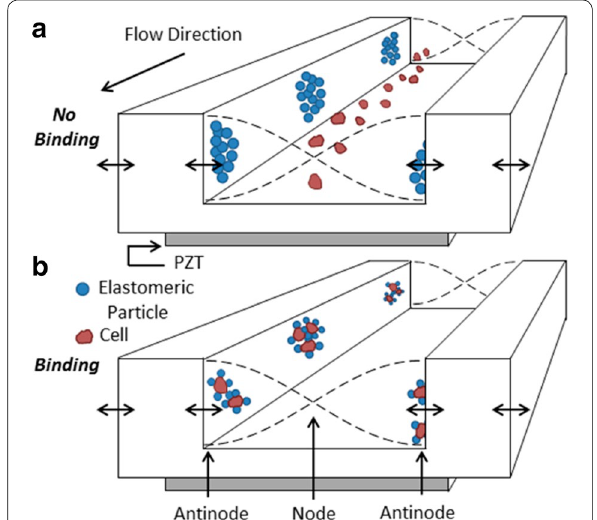
Fig. 2 Acoustic confinement of cells in a rectangular acoustofluidic device. a Unbound cells and elastomeric particles in an acoustic standing wave. b Bound cell-particle complexes in an acoustic stand- ing wave (Adapted from Shields et al.